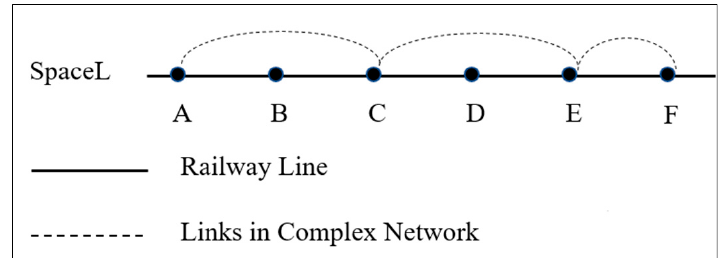
Figure 2. Complex railway network modeling.